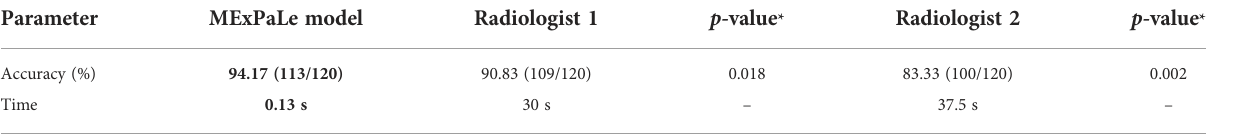
TABLE 5 Overall accuracy and times for model and radiologists ’ classi fi